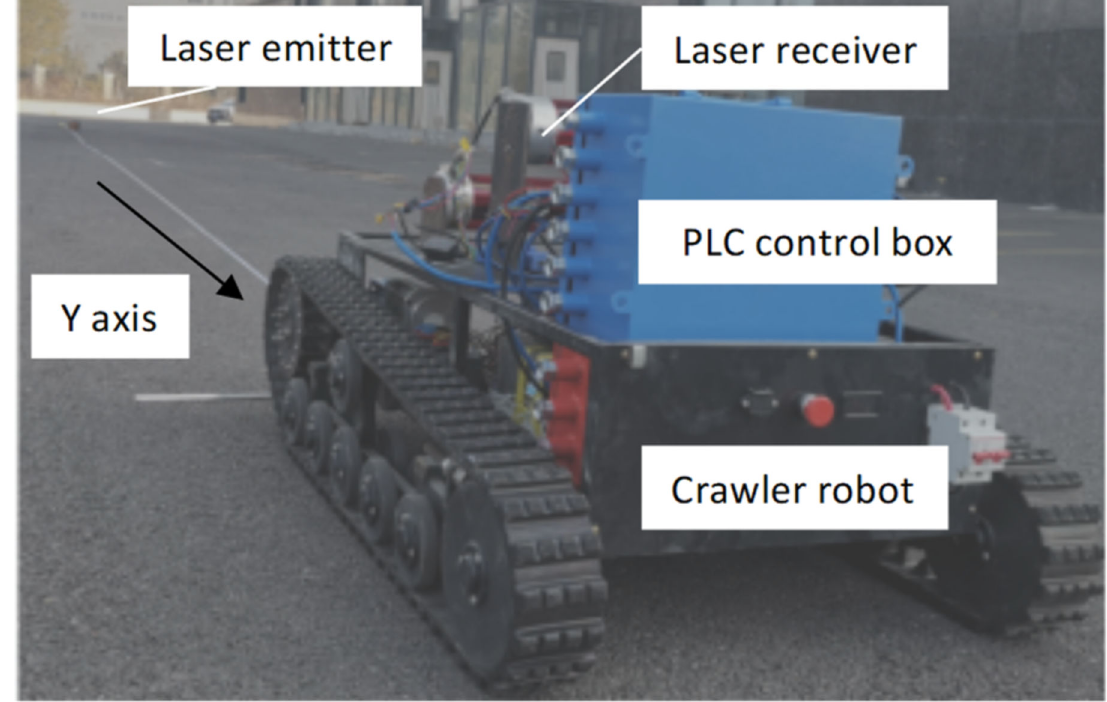
Figure 14. The experiment set. The parameters of each experimental device are shown in the Tables